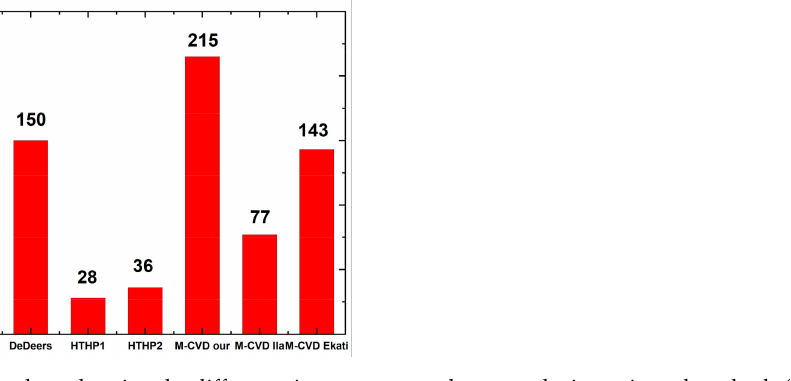
Figure 5. Bar chart showing the difference in energy usage between the investigated methods (HTHP1 refers to Apollo Diamond, HTHP2 refers to “850-press”).